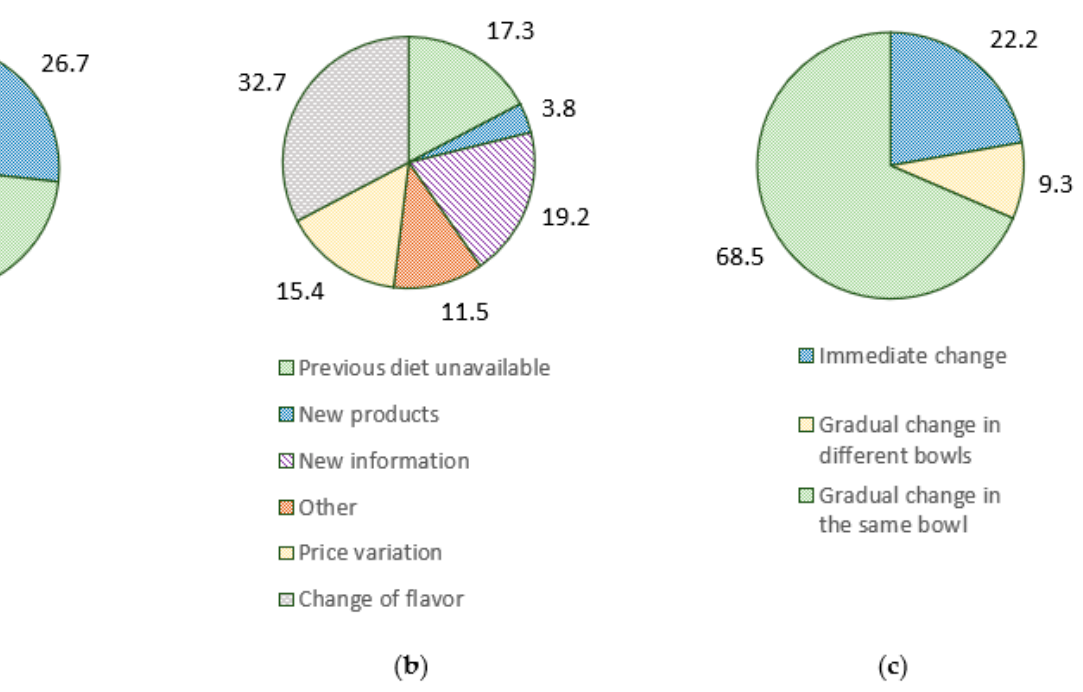
Figure 2. Feeding habits of Portuguese owners responding the survey regarding the number of daily feedings ( a ), reasons behind diet changes ( b ), and the way that diet change is conducted ( c ). 3.4. Exercise, Affective Feeding, and Body Condition